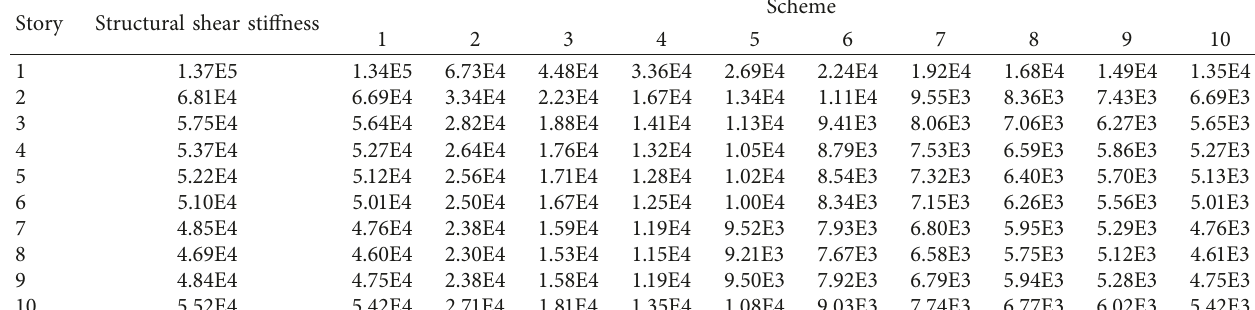
Table 2: Detailed damper parameters k